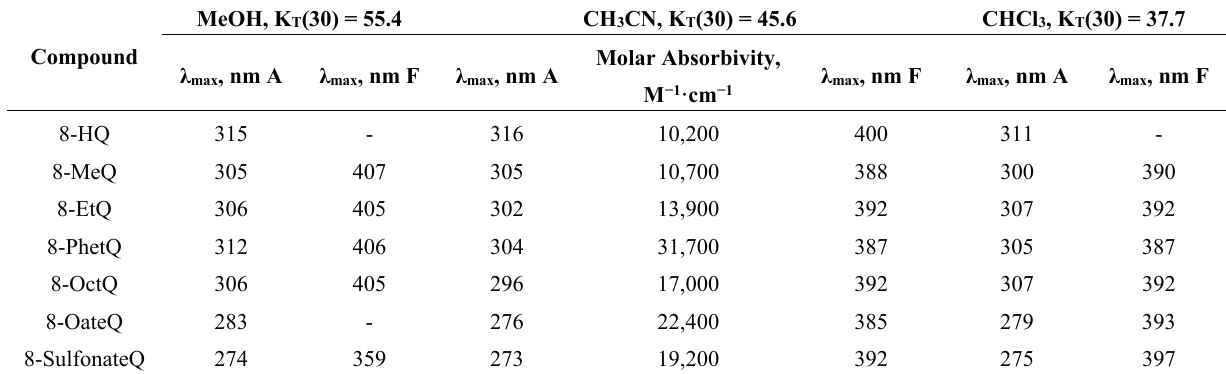
Table 1. Solvent effects on the absorption and fluorescence properties of 8-HQ and its